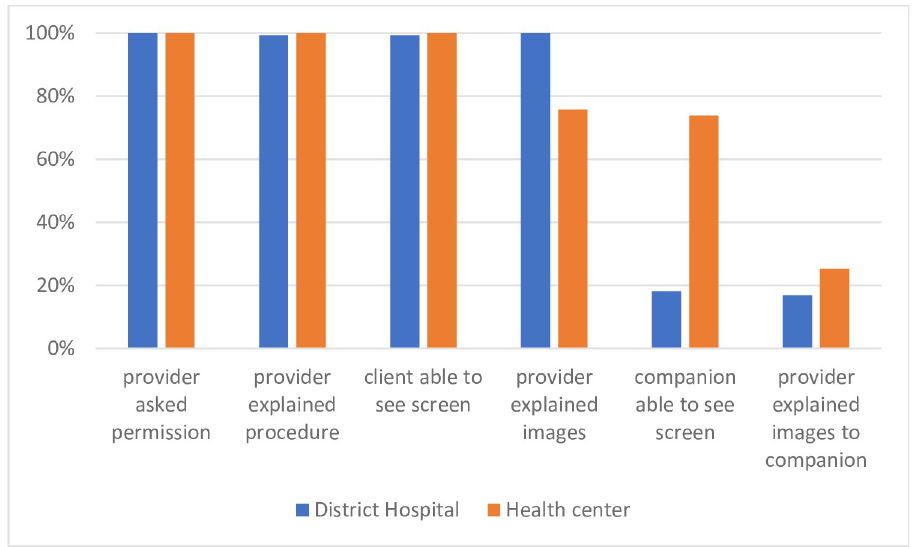
Fig 1. Patients’ perception on ultrasound at the different health facilities during Phase 3 (n = 103 health centers; n = 320 district hospital).